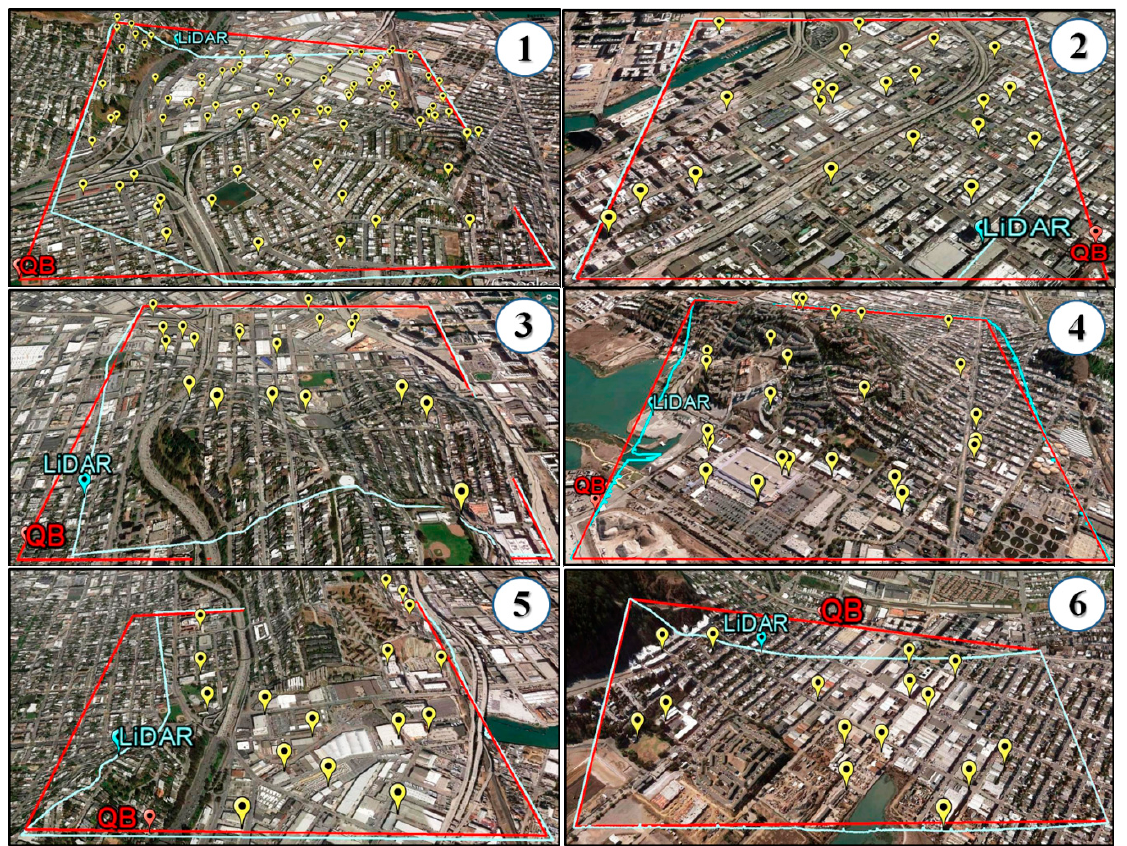
Figure 1. The area covered by the LiDAR data and the QB image in the applied data set. Control points in each dataset are shown via yellow marks. Table 1. Specifications of the applied data sets.